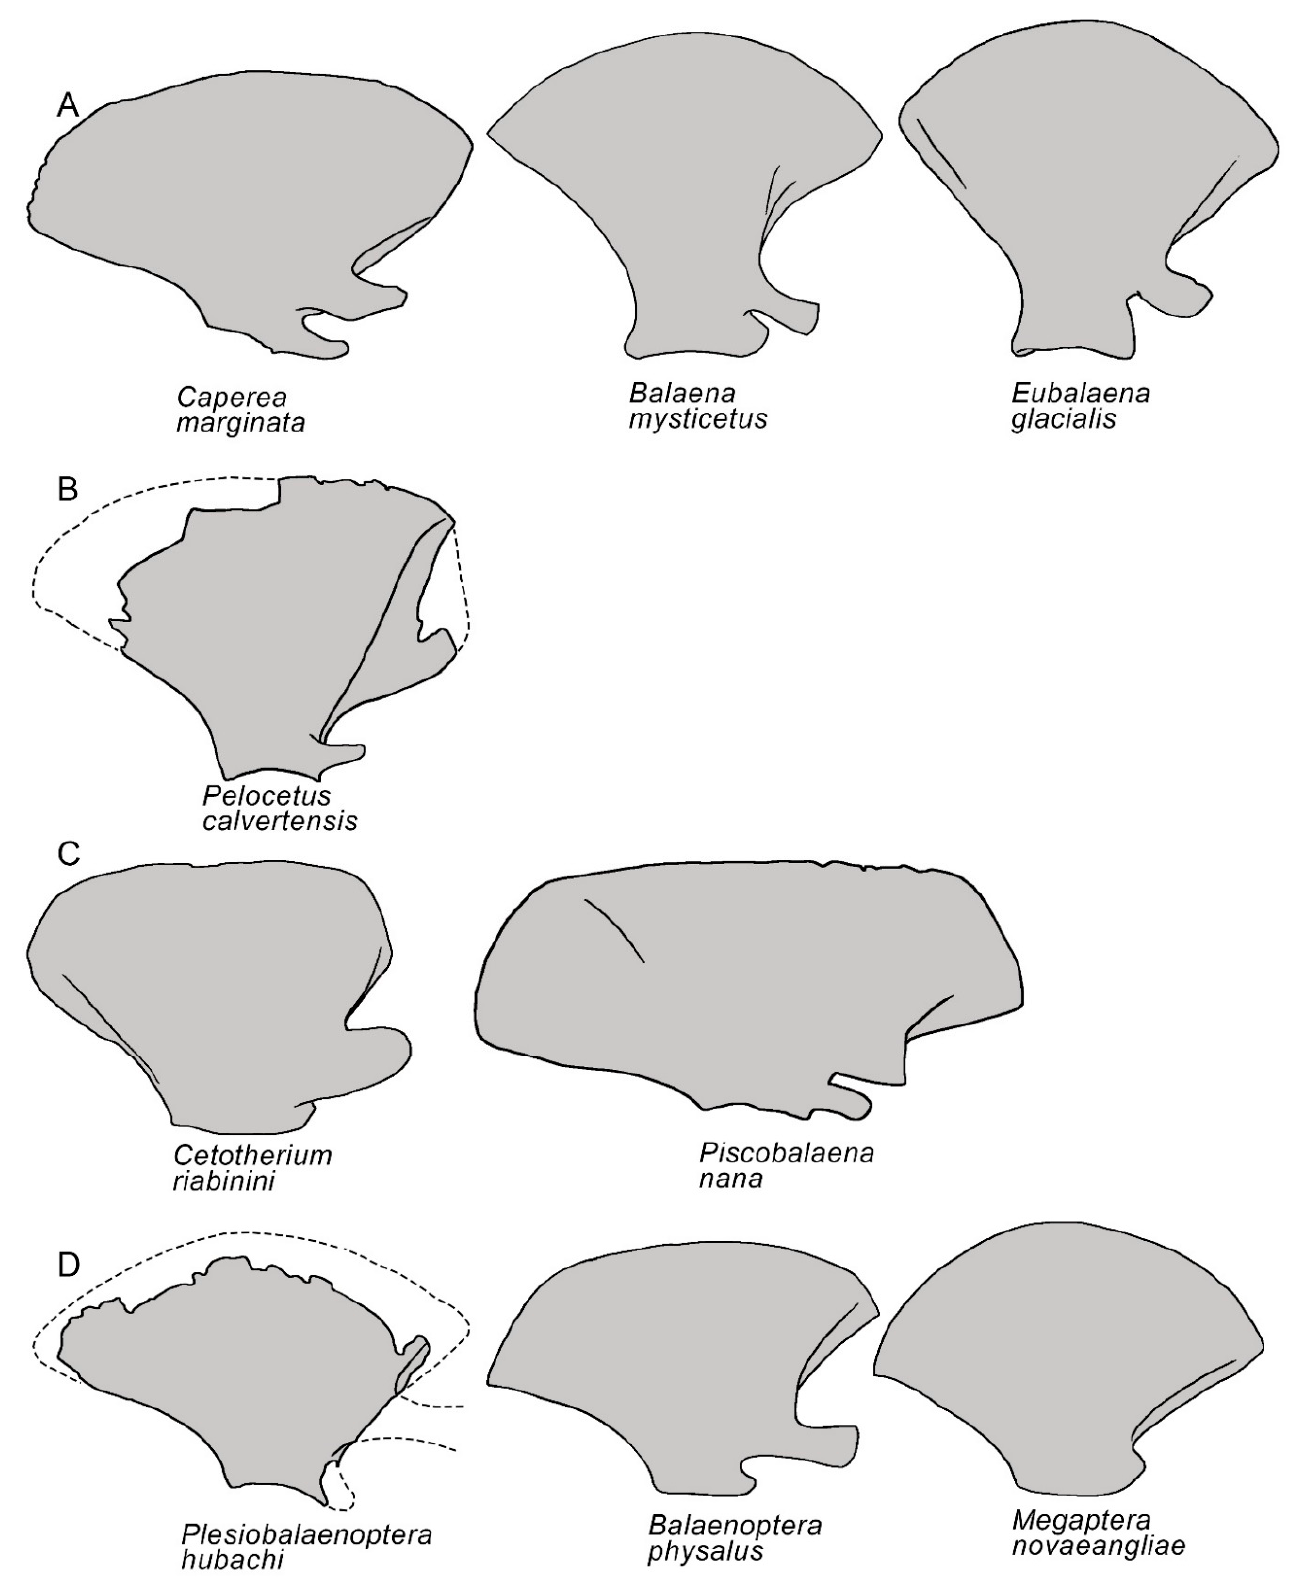
Figure 21. Scapulae of balaenomorph mysticetes. ( A ) Balaenoidea. ( B ) A basal thalassotherian taxon. ( C ) Cetotheriidae. ( D ) Balaenopteroidea. Not to scale. The scapulae are represented as if they shared the same anteroposterior length.